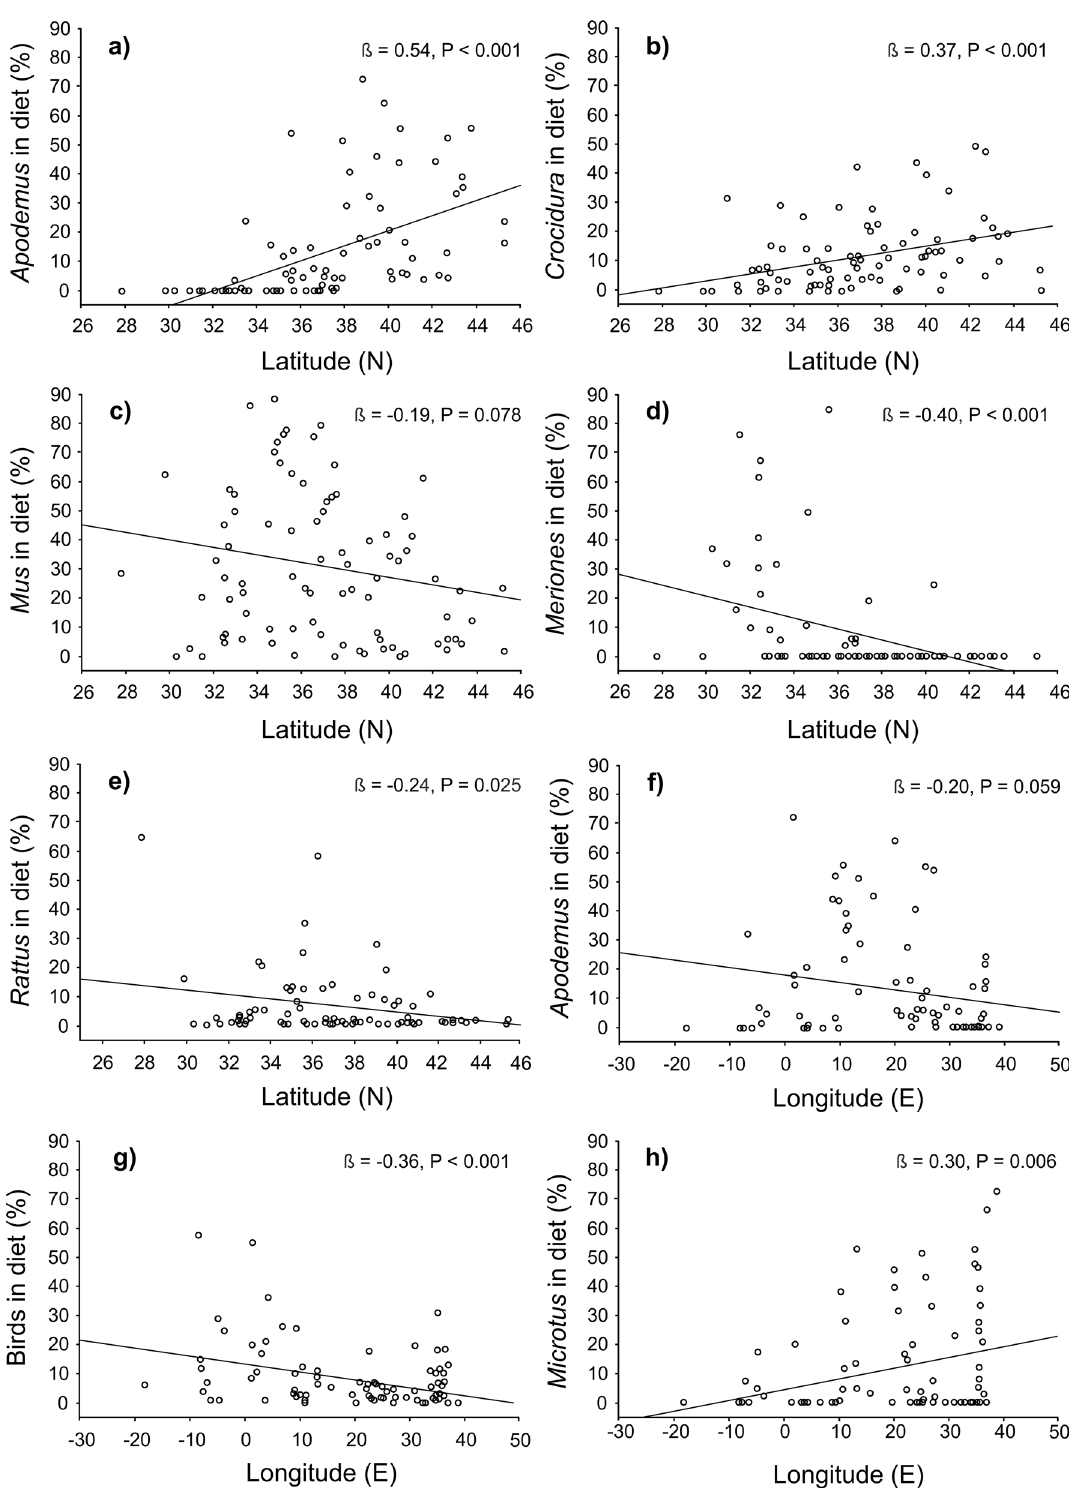
Figure 5. Relationships between latitude and the proportion of Apodemus ( a ), Crocidura ( b ), Mus ( c ), Meriones ( d ) and Rattus ( e ) in the diet of Barn owl, and relationships between longitude and the proportion of Apodemus ( f ), birds ( g ) and Microtus ( h ) in the diet (n = 85